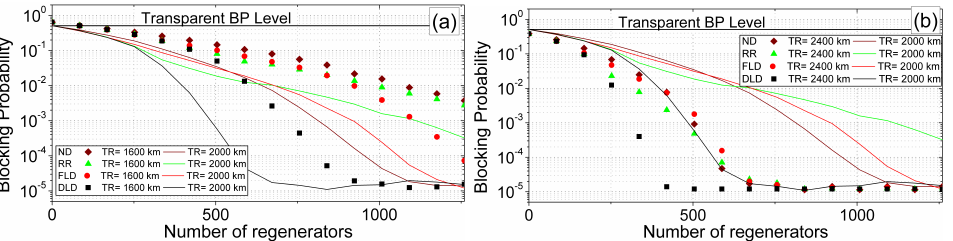
Figure 11. Blocking probability as a function of the total number of regenerators in the EuroNet topology assuming transparent reaches of: ( a ) T R = 1600km; ( b ) T R = 2400km, each compared against the reach of T R = 2000km.